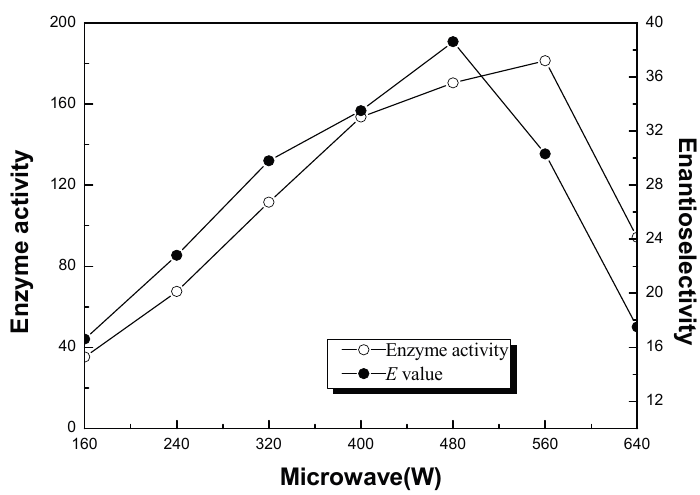
Figure 2. Effect of microwave power on the enzyme activity ( μ mol/mg/h, ○ ) and enantioselectivity ( E value, ● ) of ionic liquid co-lyophilized CLL in enantioselective esterification of α -lipoic acid. Reaction conditions: ( R , S )- α -lipoic acid (2 mmol), CLL (10 mg) co-lyophilized with 20% of [Bmim] BF 4 (wt %, IL/enzyme), n -octanol (5 mmol) and cyclohexane (10 mL) were performed at 30 °C under microwave with various power (W).